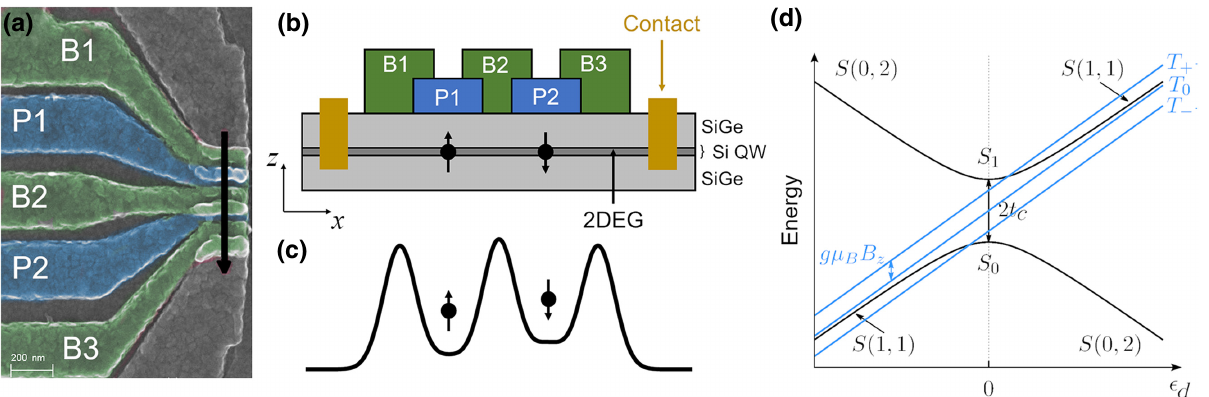
FIG. 2. The semiconductor quantum dot setup. (a) A false-color scanning-electron micrograph of a double-quantum-dot (DQD) device formed by plunger (blue) and barrier (green) gates. (b) The scheme of the device. (c) The electrostatic potential energy surface along the current path [the black arrow in (a)]. (d) The eigenenergies of the DQD with two electrons for a given detuning (cid:2) d and magnetic field B z